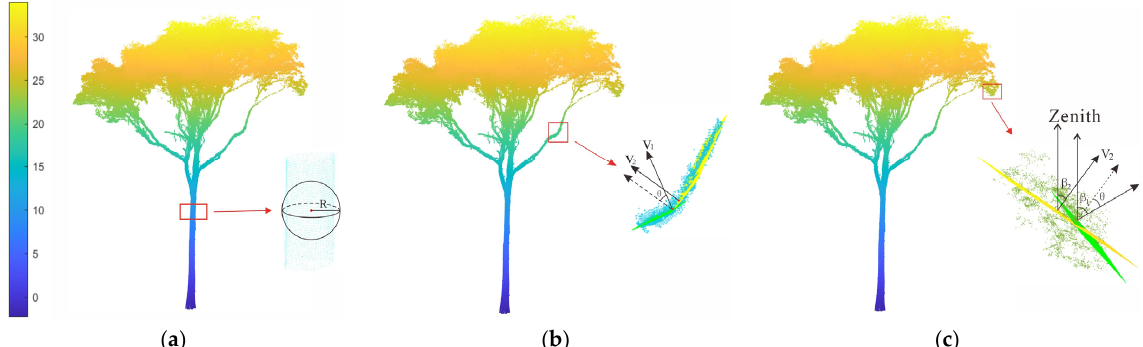
Figure 3. Graph segmentation constraints: ( a ) the constraint of neighborhood radius; ( b ) the constraint of the angle between normal vectors; ( c ) the constraint of the vertical angle gradient.